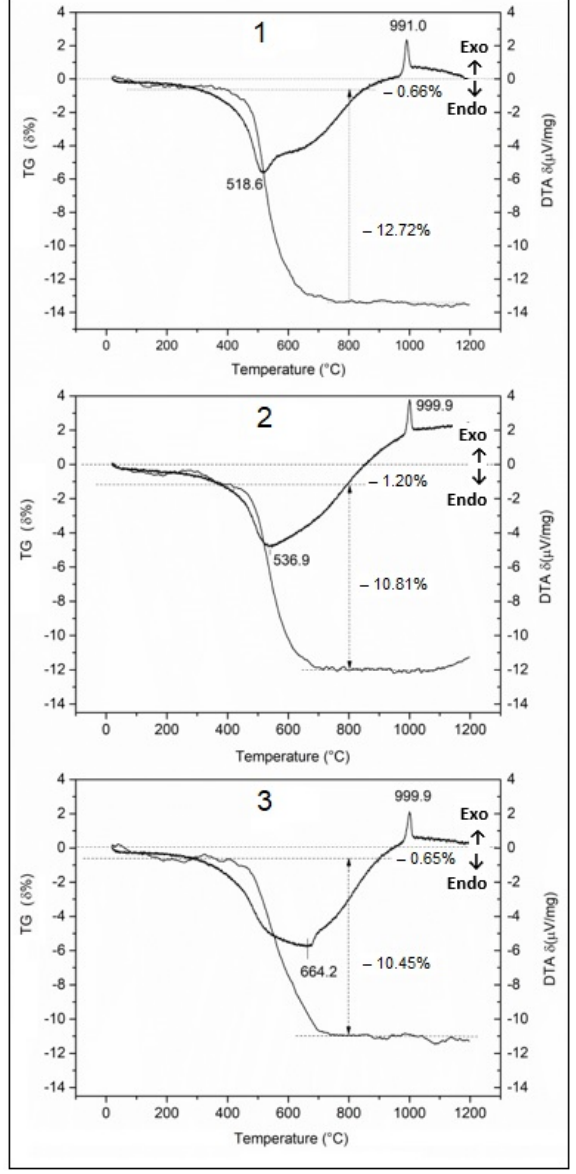
Figure 1. Thermal curves of kaolin samples